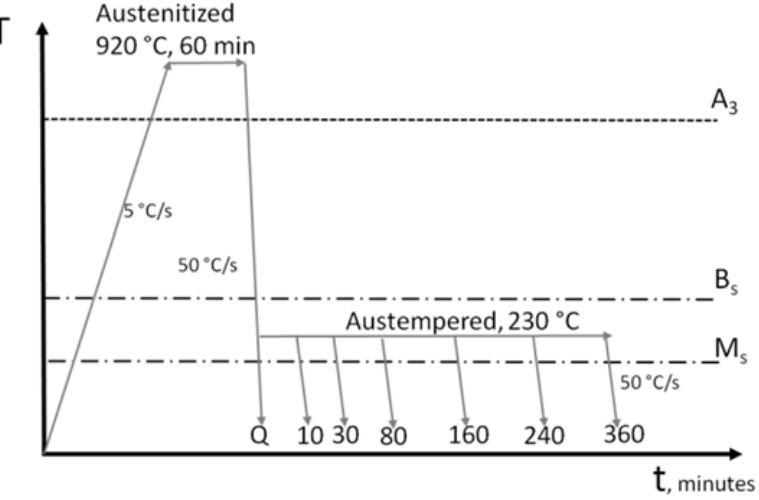
Figure 2. Schematic view of the heat treatments schedules (temperature vs time) used in this